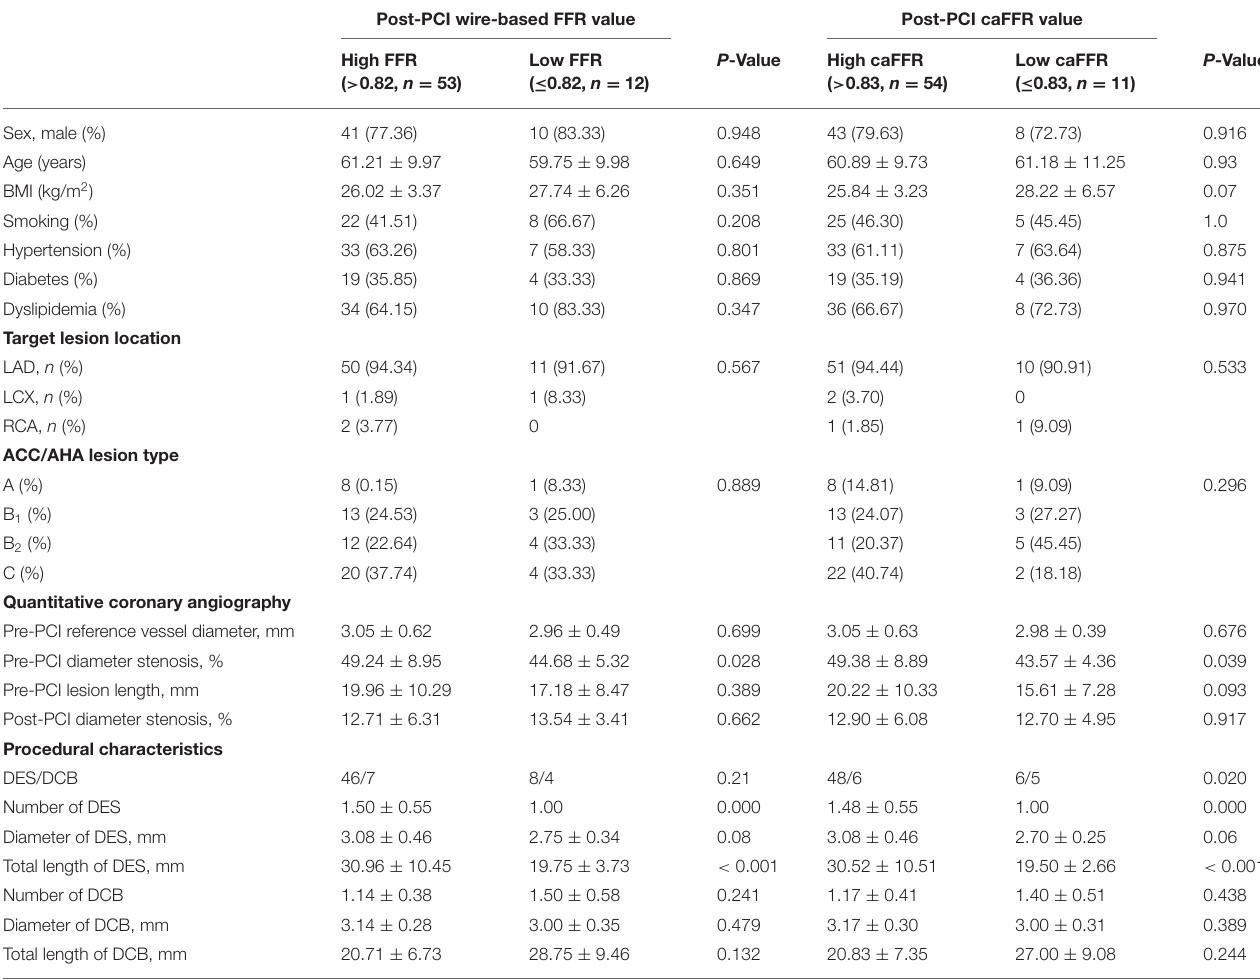
FFR, fractional flow reserve; caFFR, coronary angiography-derived FFR; BMI, body mass index; FBG, fasting blood glucose; LDL-C, low-density lipoprotein cholesterol; LVEF, Left ventricular ejection fraction; LAD, left anterior descending artery; RCA, right coronary artery; LCX, left circumflex artery; ACC, American College of Cardiology; AHA, American Heart Association; PCI, percutaneous coronary intervention; DES, drug-eluting stent; DCB, drug-coated